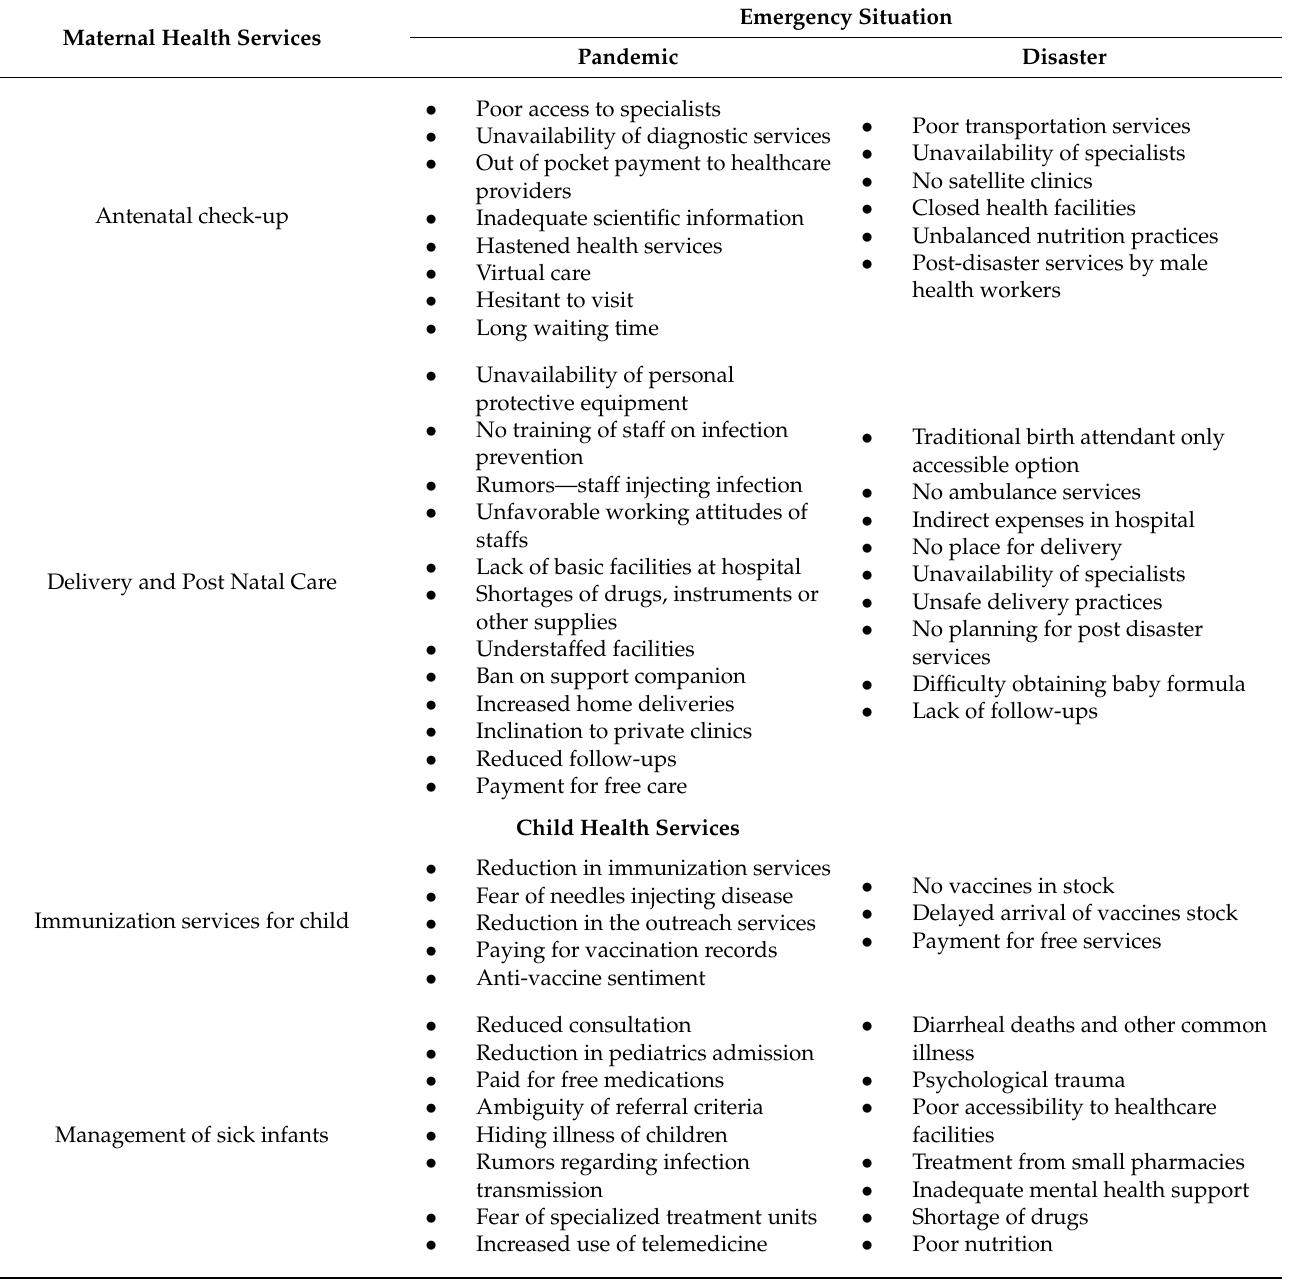
Table 2. Major challenges in maternal and child health services during pandemic or